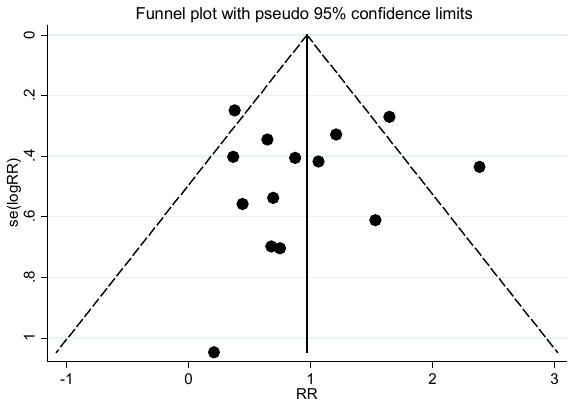
Figure 7: Begg’s funnel plot and corresponding 95% CI for Pemetrexed versus Gefitinib as second-line treatment for advanced